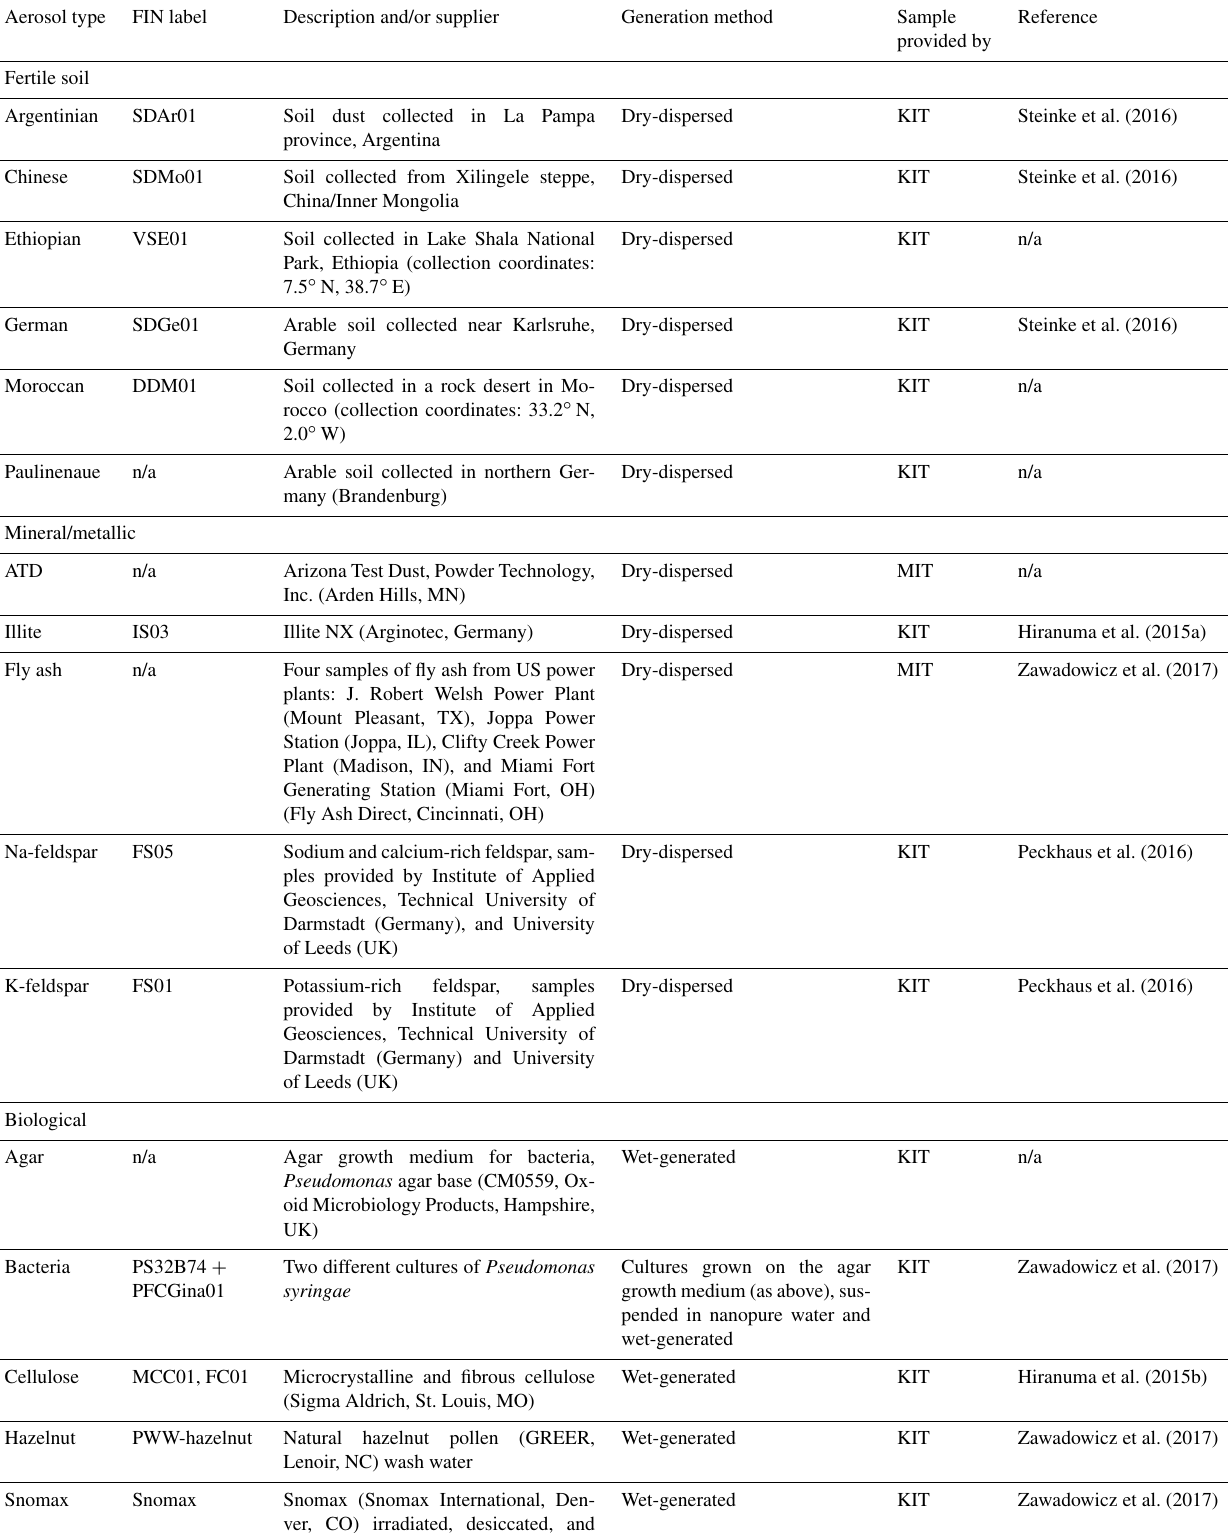
Table 1. Description of aerosol types used in the training data set. Rows are grouped by broad aerosol categories in the following order: fertile soil, mineral/metallic, biological, and other. “n/a” stands for not applicable. Aerosol